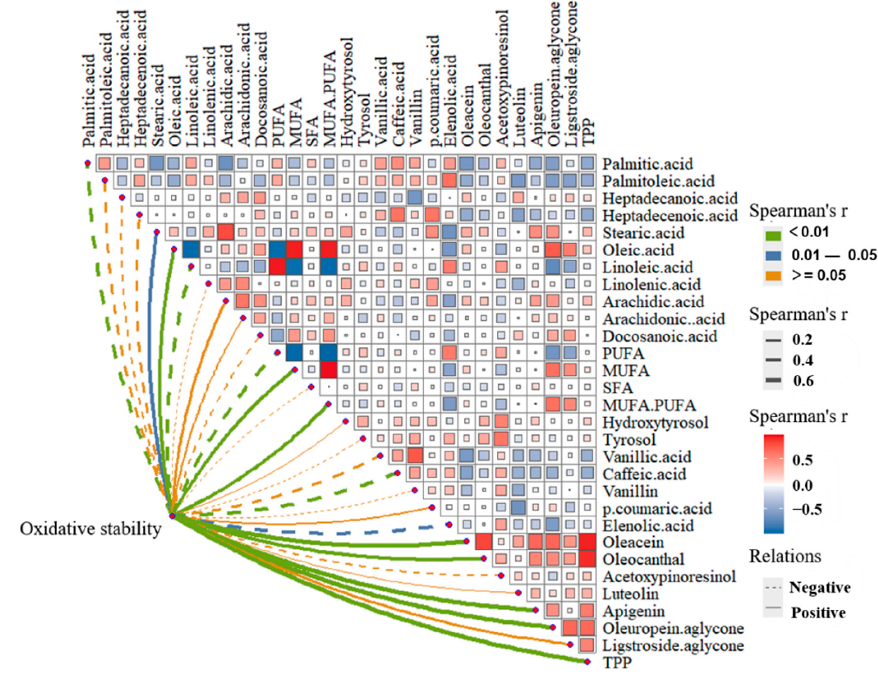
Figure 2. Analysis of the correlations between phenolic compounds, fatty acids and oxidative stability. 1 Saturated fatty acid (SFA), polyunsaturated FA (PUFA), monounsaturated fatty acid (MUFA), total polar phenolics